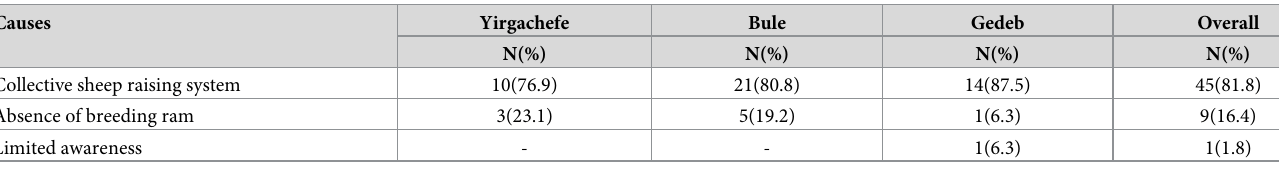
Table 5. Causes of uncontrolled breeding.